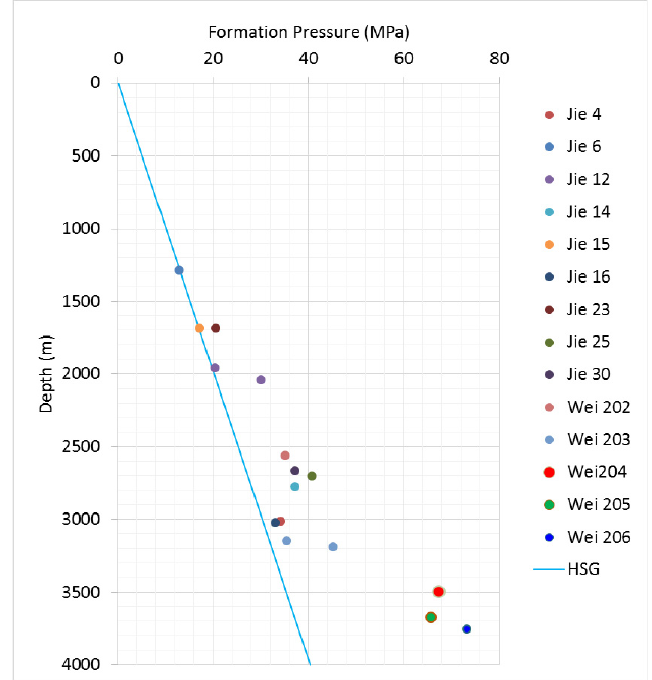
Figure 4. Pore pressure measurements in the reginal wells.